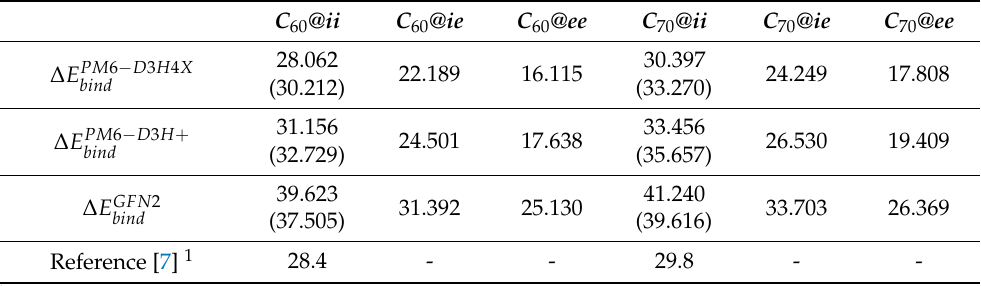
Table 2. Interaction energies for the buckycatcher fullerene complexes according to several semi- empirical methods. Interaction energies are in kcal/mol. Two sets of interaction energies are reported here for conformer ii : the main set corresponds to the method-specific interaction energies, based on the respective optimized structures; the second set corresponds to structures as reported in the S12L database [13] (in parenthesis).